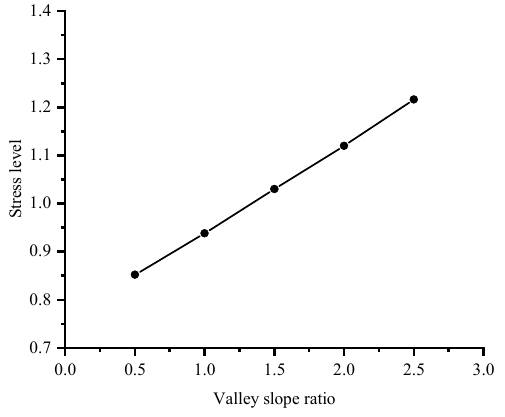
Figure 10. Relationship between settlement maximum of ACC and valley slope ratio.